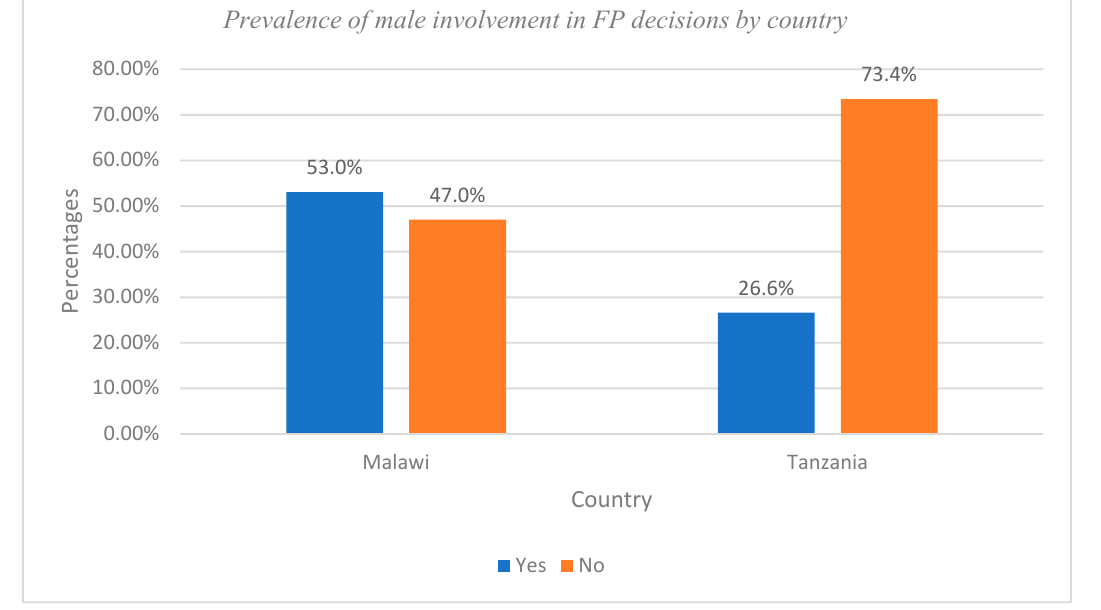
Figure 1. Prevalence of male involvement in FP decisions in Malawi and Tanzania.